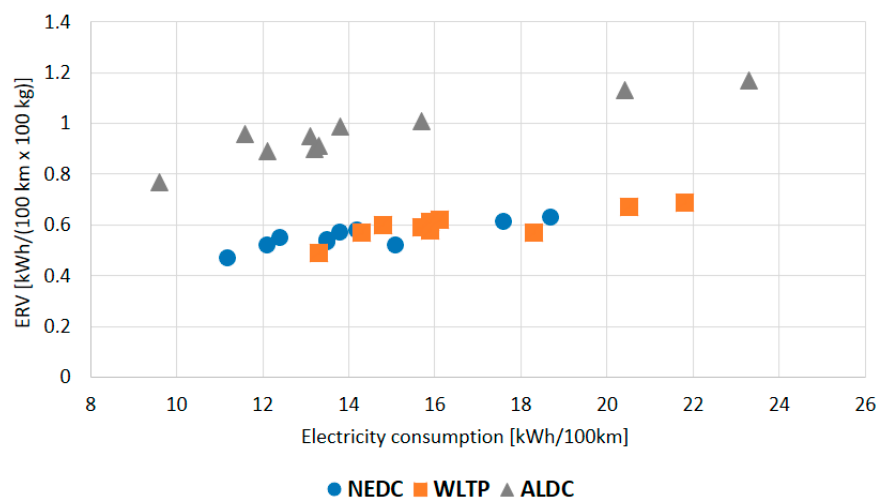
Figure 5. ERV for all case studies in function of electricity consumption.